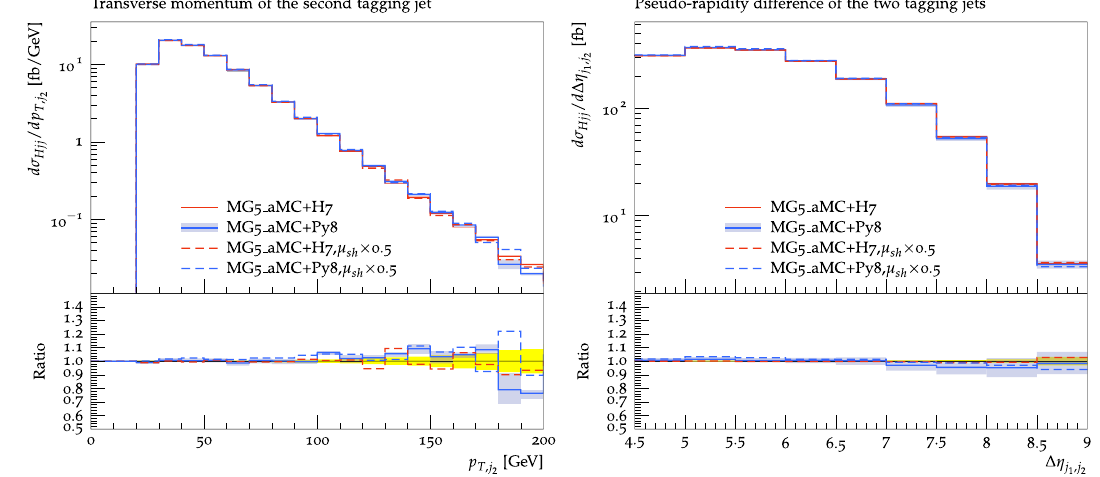
Fig. 3 Same as in Fig. 2, for the transverse momentum of the second tagging jet (left) and for the rapidity separation of the two tagging